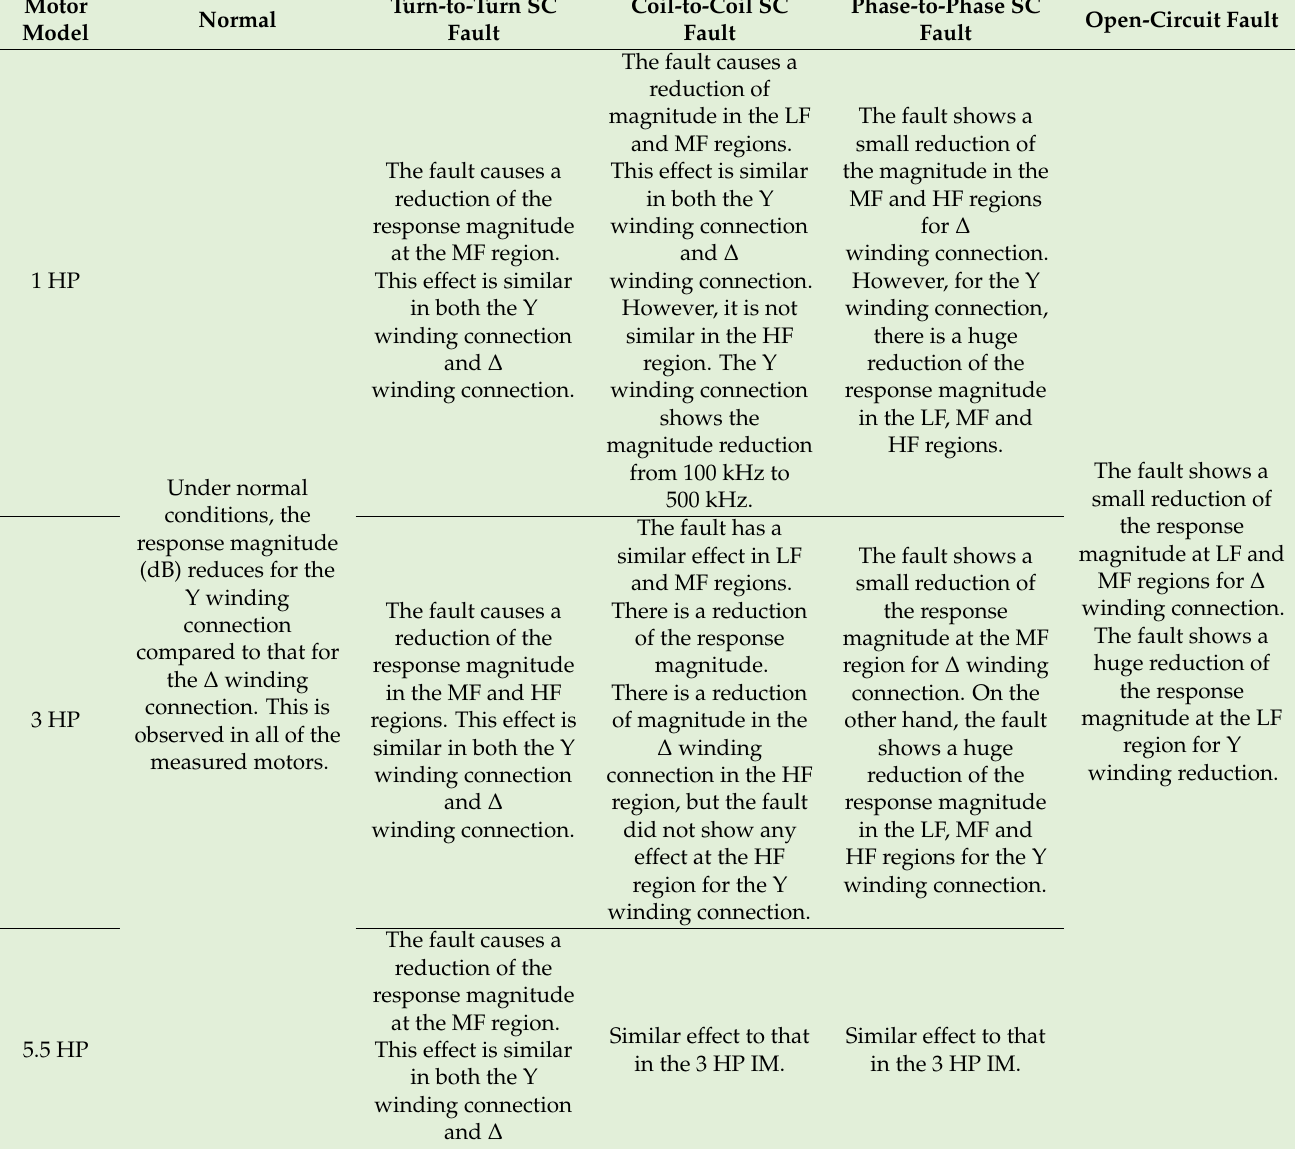
Table 2. General comparison of the FRA measurement patterns of (Y) and ( ∆ ) in normal and fault